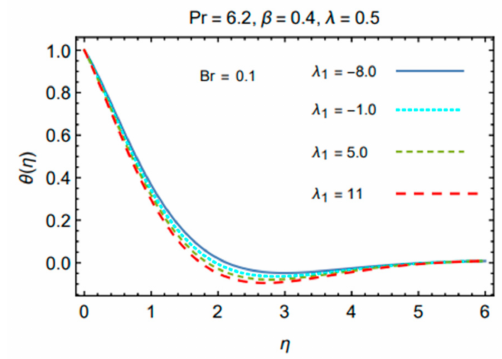
Figure 6. Variation in θ ( η ) against λ 1 .